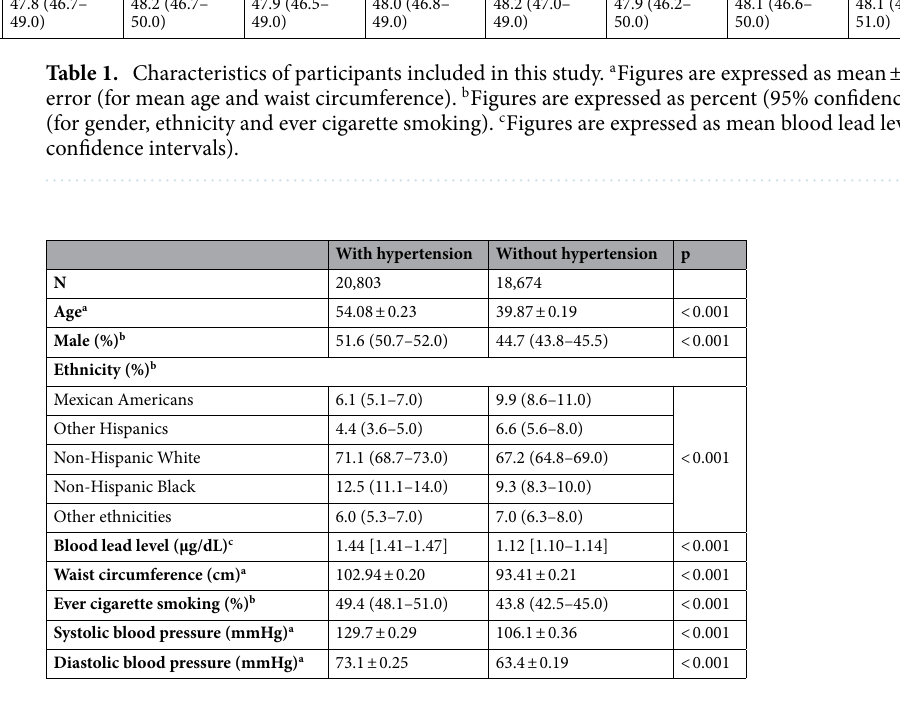
Table 2. Characteristics of participants included in this study (subgroup analysis by hypertension). a Figures are expressed as mean ± standard error (for mean age, waist circumference, systolic blood pressure and diastolic blood pressure). b Figures are expressed as percent (95% confidence intervals) (for gender, ethnicity and ever cigarette smoking). c Figures are expressed as mean blood lead levels (95% confidence